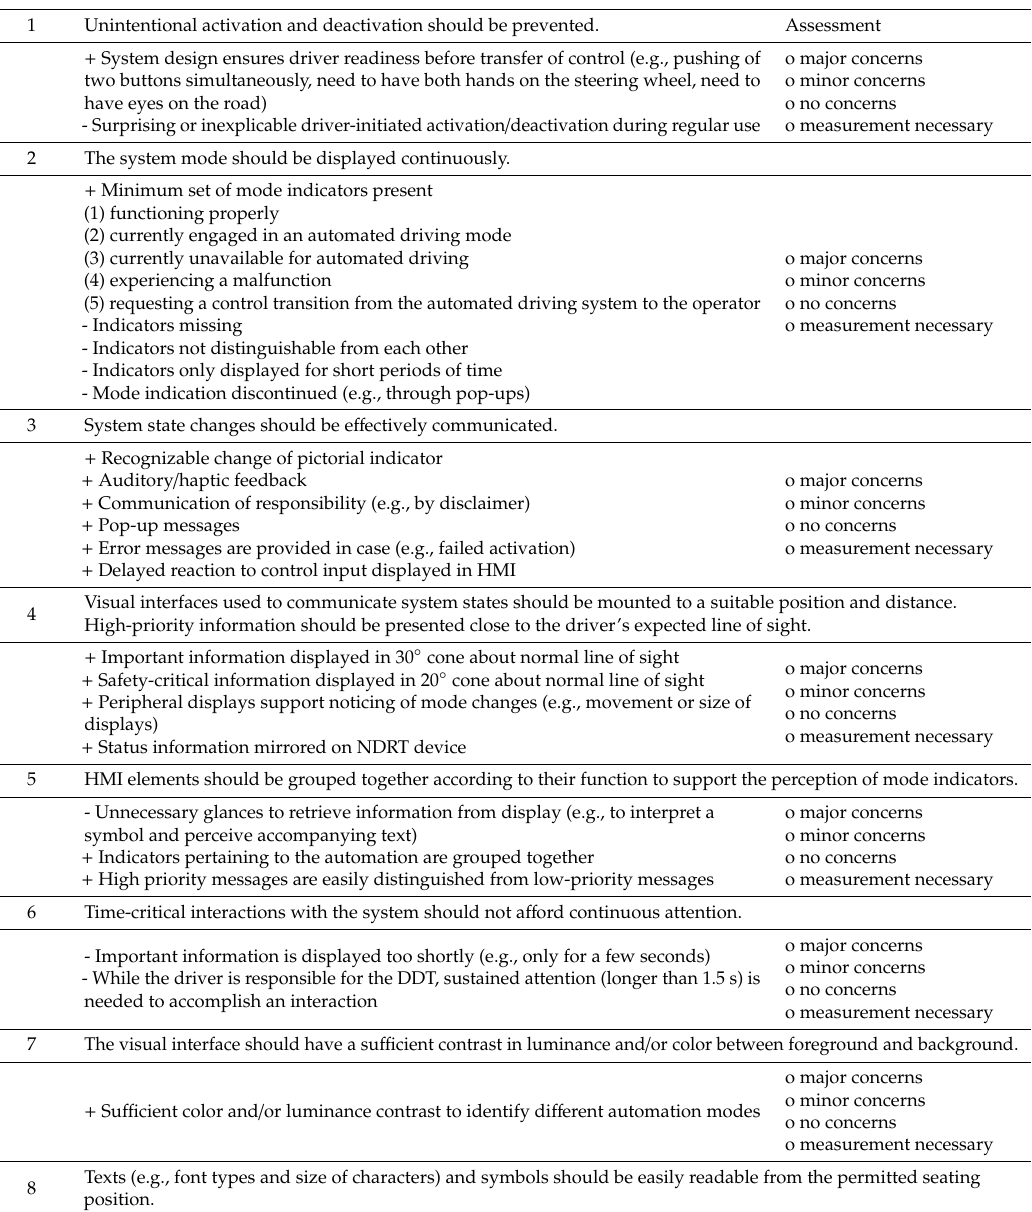
Table A1. Extended checklist items (see [5]). NHTSA, U.S. National Highway Tra ffi c Safety Administration. Abbreviations in the table: NDRT = Non-driving-related task; DDT = Dynamic Driving